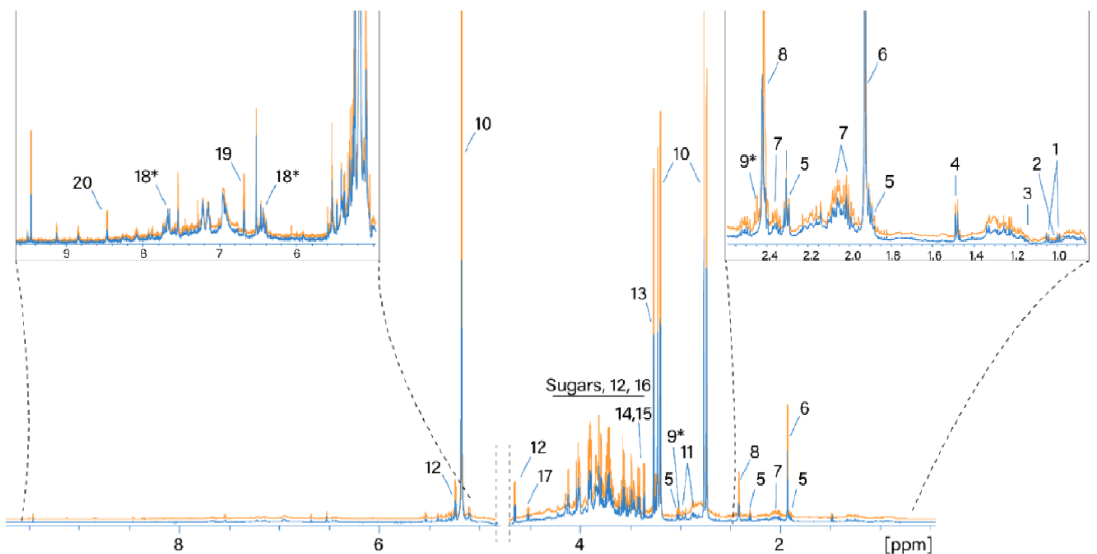
Figure 1. Normalized 1 H NMR spectra of water extracts of SD- and TD-processed H. sabdariffa calyces. Blue: SD samples; orange: TD samples. 1: Valine; 2: isoleucine; 3: ethanol; 4: alanine; 5: GABA; 6: acetate; 7: proline; 8: succinate; 9: 2-oxoglutarate*; 10: hibiscus acid; 11: asparagine; 12: glucose; 13: betaine; 14: scyllo-inositol; 15: methanol; 16: fructose; 17: arabinose; 18: maltol*; 19: fumaric acid. *: Tentative assignment. Table 2. Resonance assignment of 1D 1 H and 2D NMR spectra of the H. sabdariffa calyxes’ water extracts. N δ .